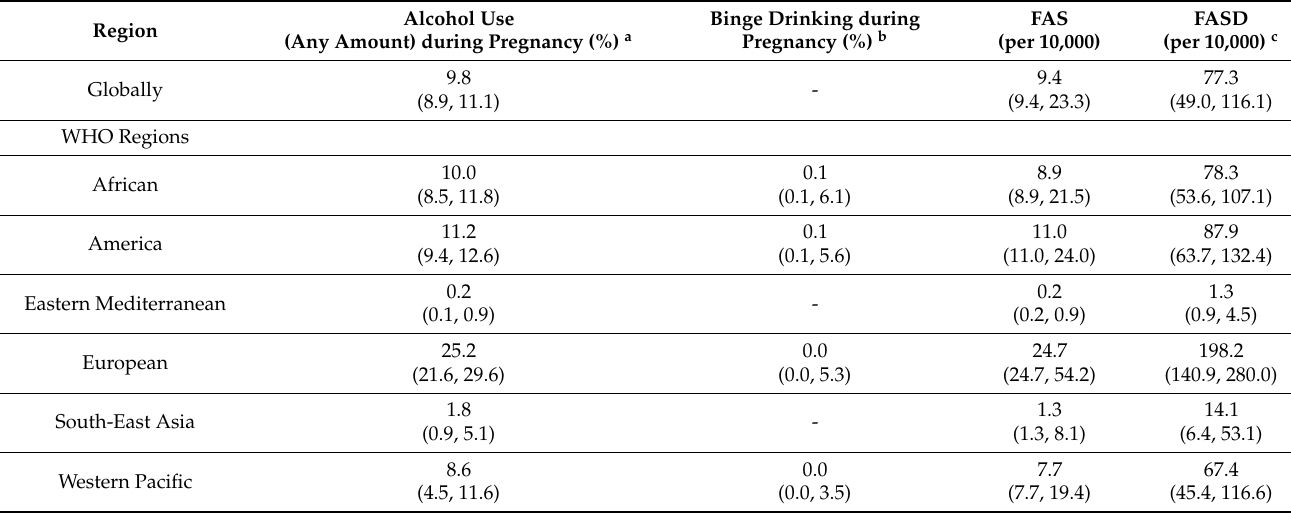
Table 2. Global prevalence of any amount of alcohol use and binge drinking (4 or more drinks on a single occasion) during pregnancy, and of FAS and FASD among the general population, by WHO Region in 2012, and corresponding 95% confidence